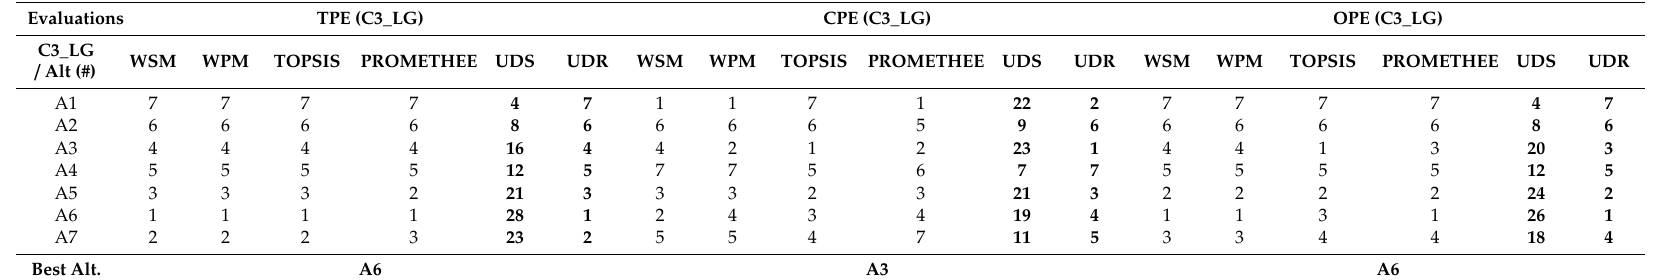
Table 18. Order of the ranks across TPE, CPE, and OPE in C3_LG for 33-bus